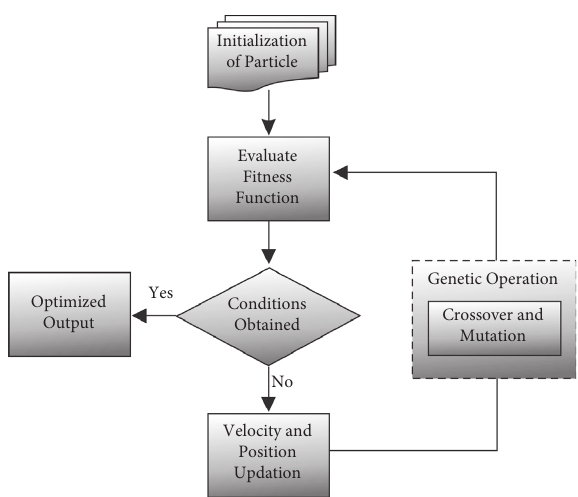
Figure 3: Flow diagram for HPSO with